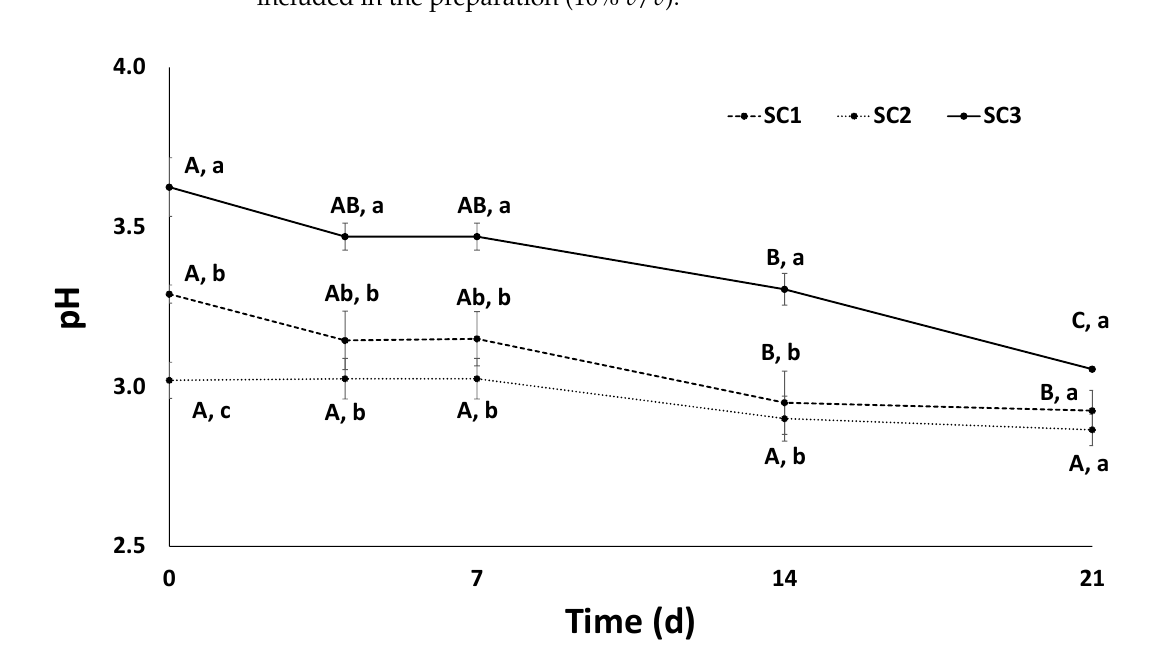
Figure 2. Evolution of pH in ST kombuchas fermented using SCOBYs 1, 2, and 3 (SC1, SC2, SC3). Different letters show statistical significance ( p ≤ 0.05) between different fermentation days for the same SCOBY (A–C) and between different SCOBYs for the same fermentation day (a–c).